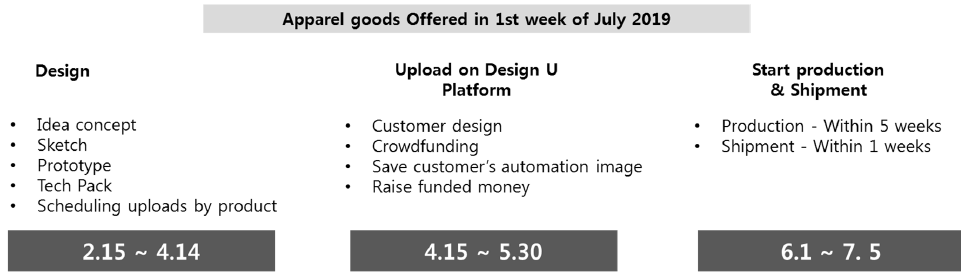
Figure 21. The customer-participated scheduling.